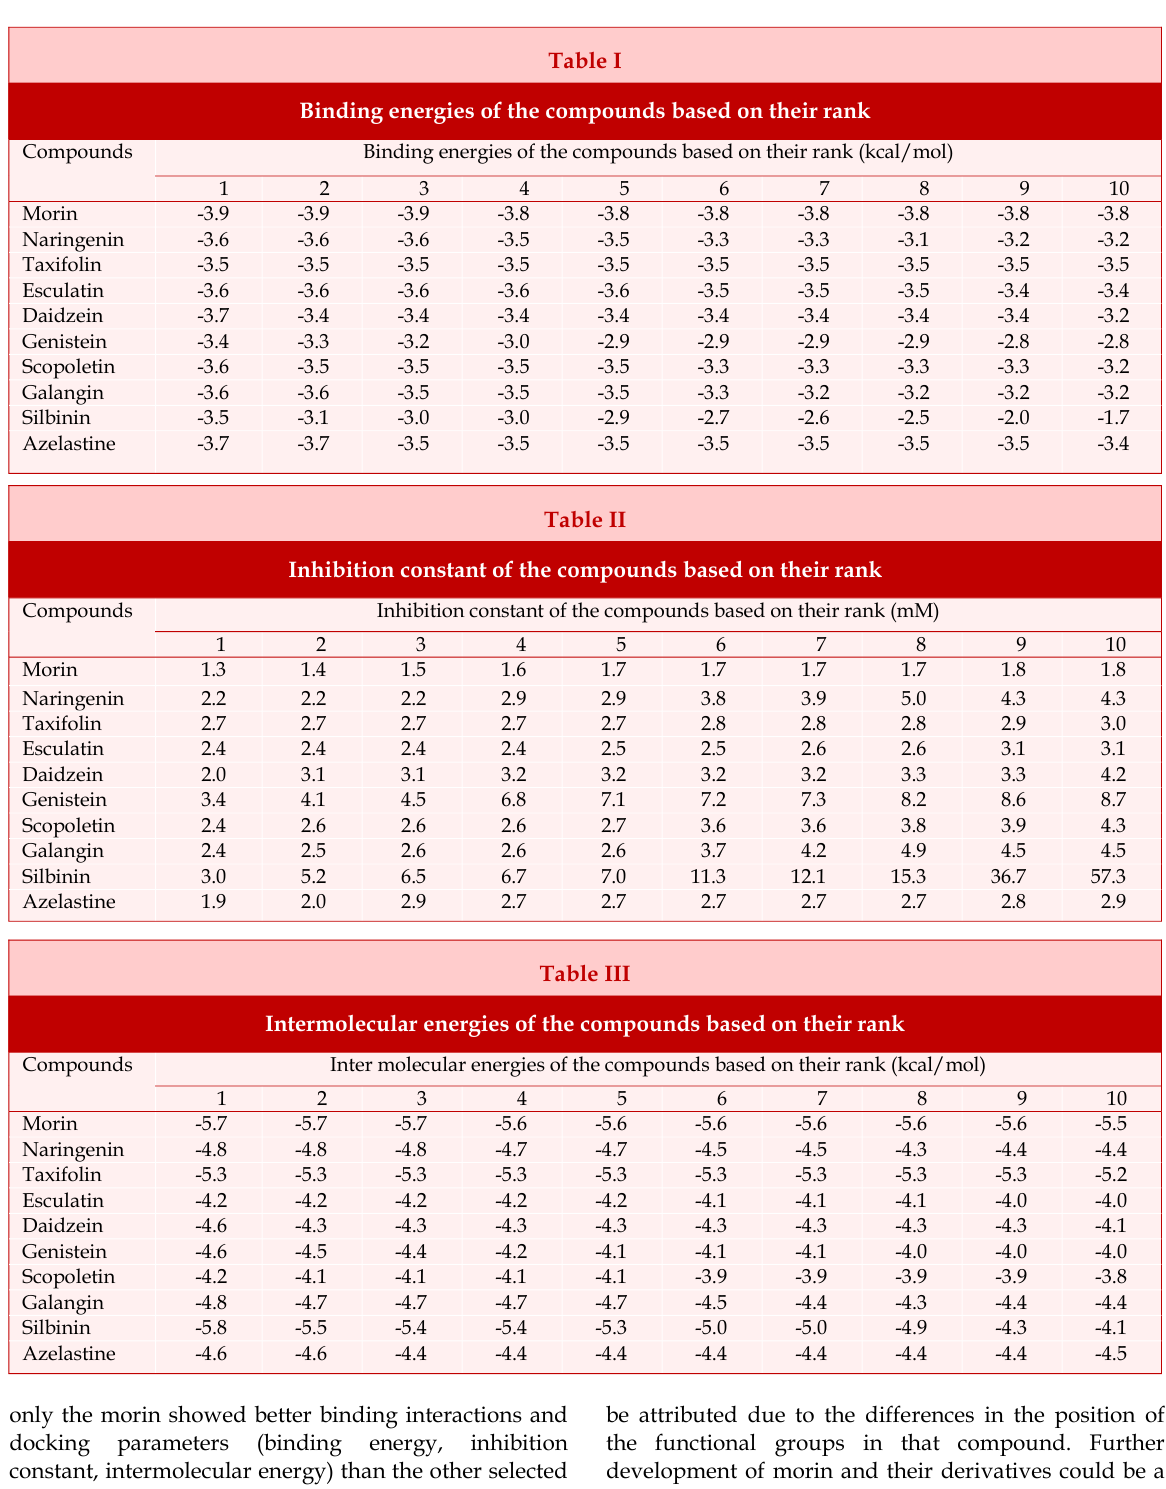
Binding energies of the compounds based on their rank